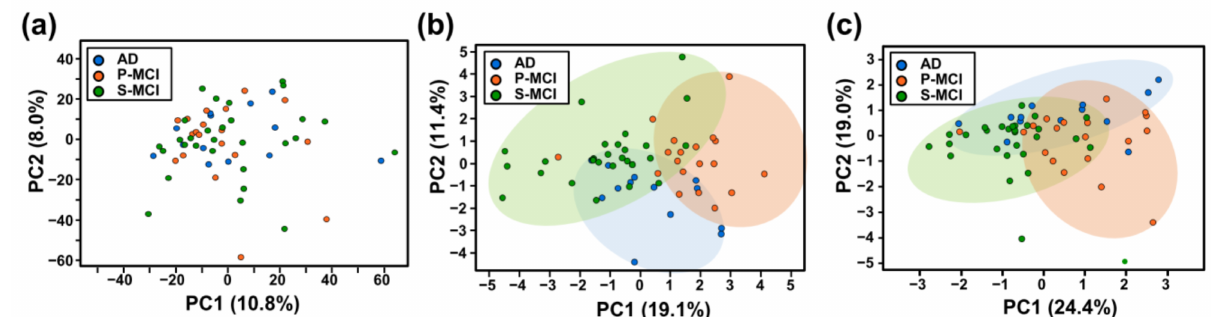
Figure 3. Principal component analysis (PCA) was used to derive the major distribution patterns from metabolomics data for all three groups. ( a ) PCA of 3749 metabolic features from 61 samples of S-MCI, P-MCI, and AD patients. ( b , c ) PCA representation of the twenty ( b ) or eight ( c ) metabolites selected by the machine learning algorithms. S-MCI, stable MCI; P-MCI, MCI proceeding to